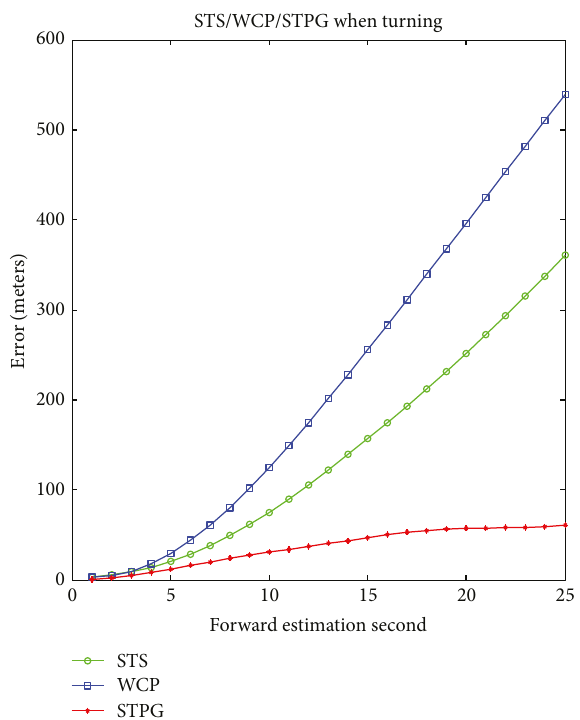
Figure 15: STS versus WCP versus STPG prediction errors when turning.